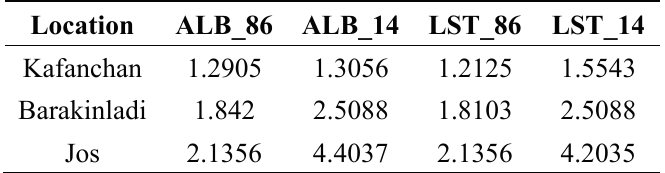
Table 14. Weighted values of albedo and LST between 1986 and 2014 in the three selected regions.